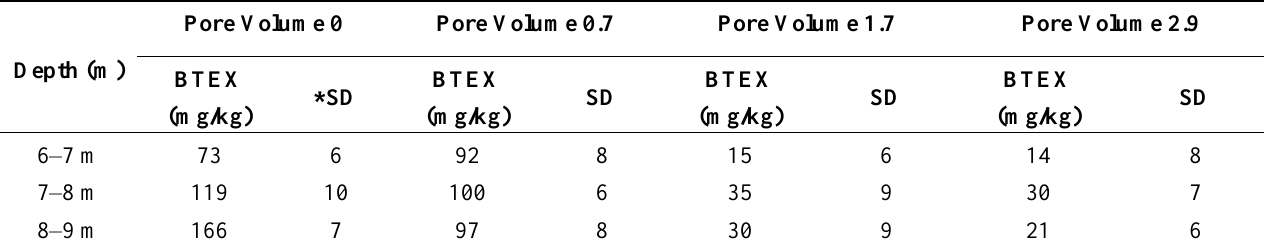
Table 4. BTEX concentrations of soils relative to the pore volume for full-scale operation at a petroleum-polluted military